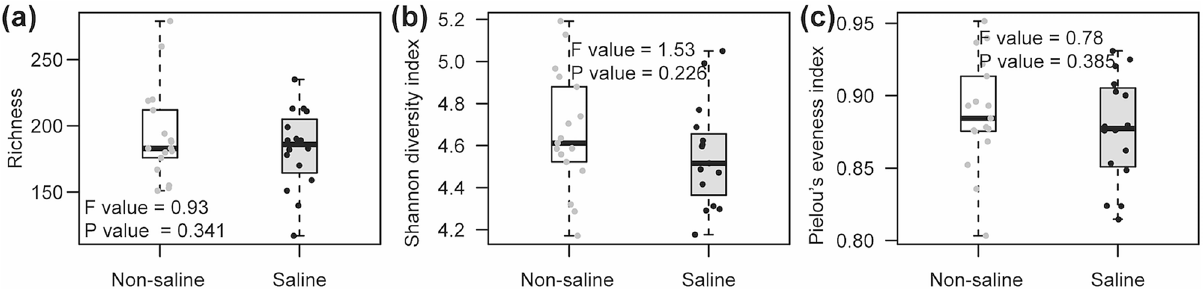
Figure 1. Effect of irrigation sources (non-saline freshwater vs saline groundwater) on date palm root- associated bacterial alpha diversity. Irrigation source effect on ( a ) bacterial richness; ( b ) Shannon diversity index; (c) Pielou’s evenness index. Statistical inference is highlighted within each panel of the plot and assessed using ANOVA analyses followed by Tukey’s HSD post hoc test ( P < 0.05). The box spans the interquartile range (IQR; first quartile to the third) with the median indicated by a dark horizontal line, the whiskers show the 1.5× IQR. Data for each sample is also displayed with strip chart.